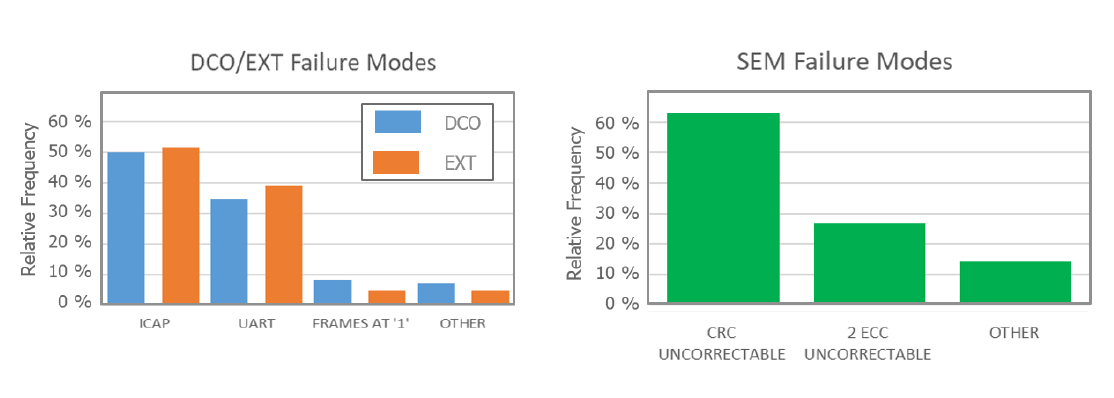
Figure 9. Classification of failure modes for the tested firmwares: ( Left ) failure mode histograms for the DCO and EXT scrubbers; and ( Right ) failure mode histogram for the